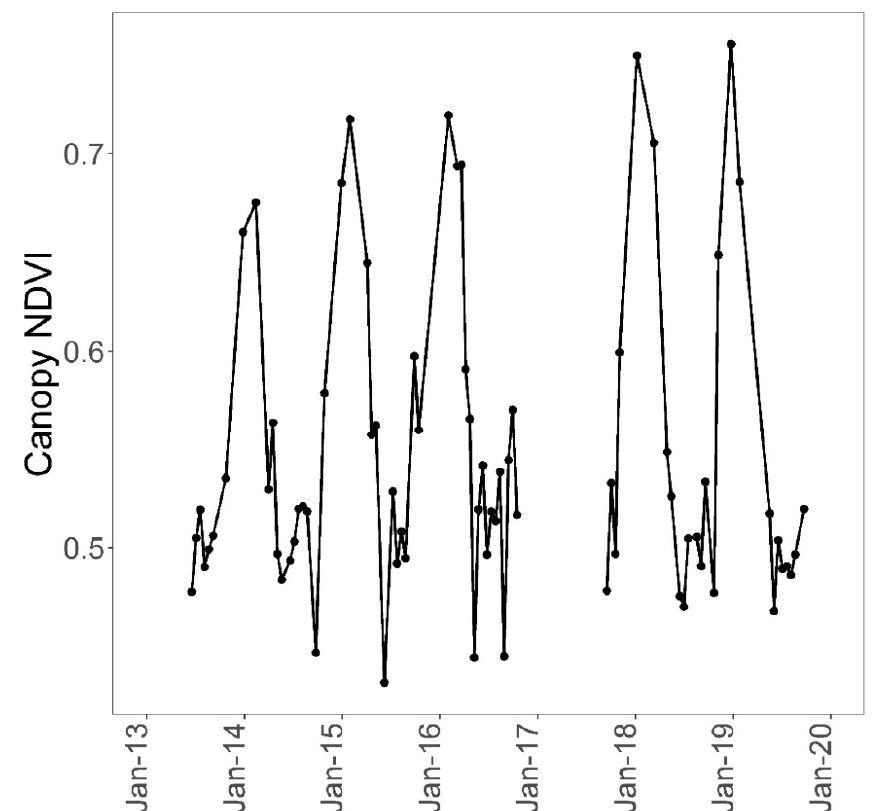
Figure 8. Time series of canopy NDVI that was retrieved from Landsat 8 NDVI for 2013–2019. Each data point refers to the canopy NDVI on a Landsat 8 imaging day.